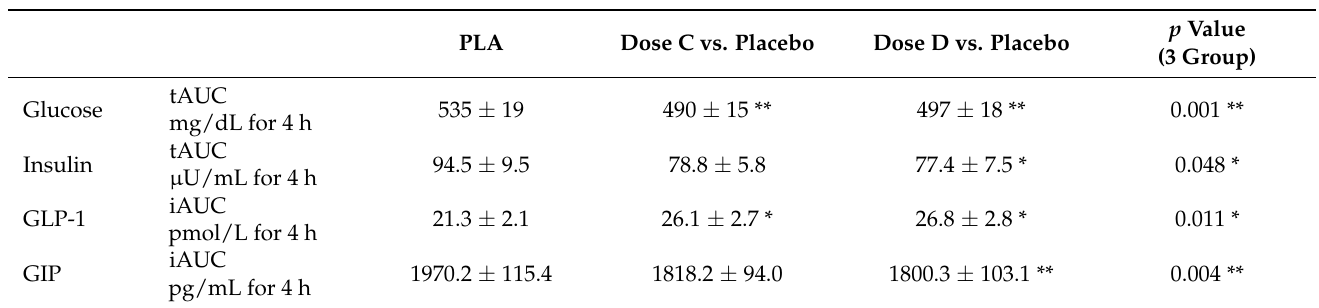
Table 4. AUC for blood-glucose-related indices and incretin up to 4 h after cookie meal ingestion in Study 2. PLA Dose C vs. Placebo Dose D vs. Placebo